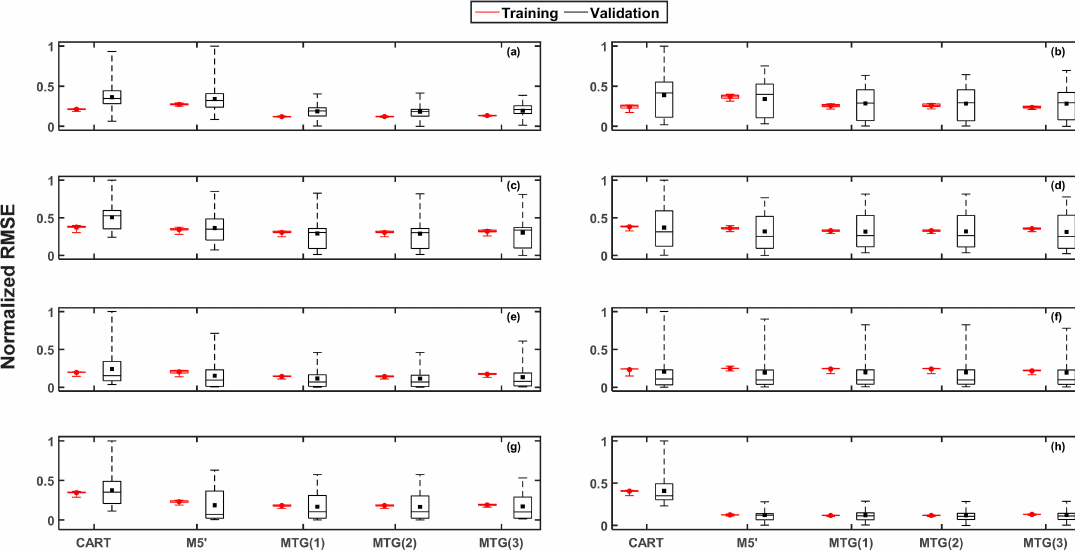
Figure 11. Boxplots and mean values of the normalized RMSE values of daily discharge for ( a ) Arkabutla, ( b ) Coralville, ( c ) Dale Hollow, ( d ) Eldorado, ( e ) Folsom, ( f ) Prado, ( g ) Shasta and ( h ) Trinity for training and validation data for CART, M5 (cid:48) , MTG(1), MTG(2), and